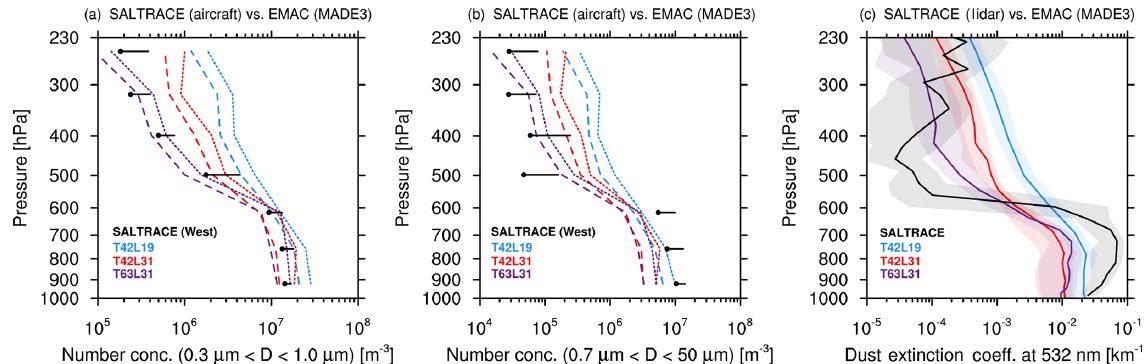
Figure 5. Comparisons between model results and different observational data from the SALTRACE mineral dust campaign (June–July 2013). (a) Data from aircraft measurements of total aerosol number concentration for particles with diameters in the range 0 . 3µm < D < 1 . 0µm are shown. Observational data from all SALTRACE-West flights (around Puerto Rico and Barbados) were binned into 1.6km height bins in order to create the vertical profiles. Dots represent mean values; whiskers represent standard deviations of observations (only positive direction shown). Mean values (long-dashed lines) and standard deviations (short-dashed lines) of the model results are shown for the three different resolutions: T42L19 (blue), T42L31 (red), and T63L31 (purple). (b) Similar to (a) but for total aerosol number concentrations in the size range 0 . 7µm < D < 50µm. (c) Simulated dust extinction coefficients compared with ground-based lidar measurements in Barbados. Simulation and lidar measurement data were binned into 500m intervals. Lines represent median values; shadings represent 25th–75th percentiles for the observations (black) and the three model setups (blue, red, and purple).